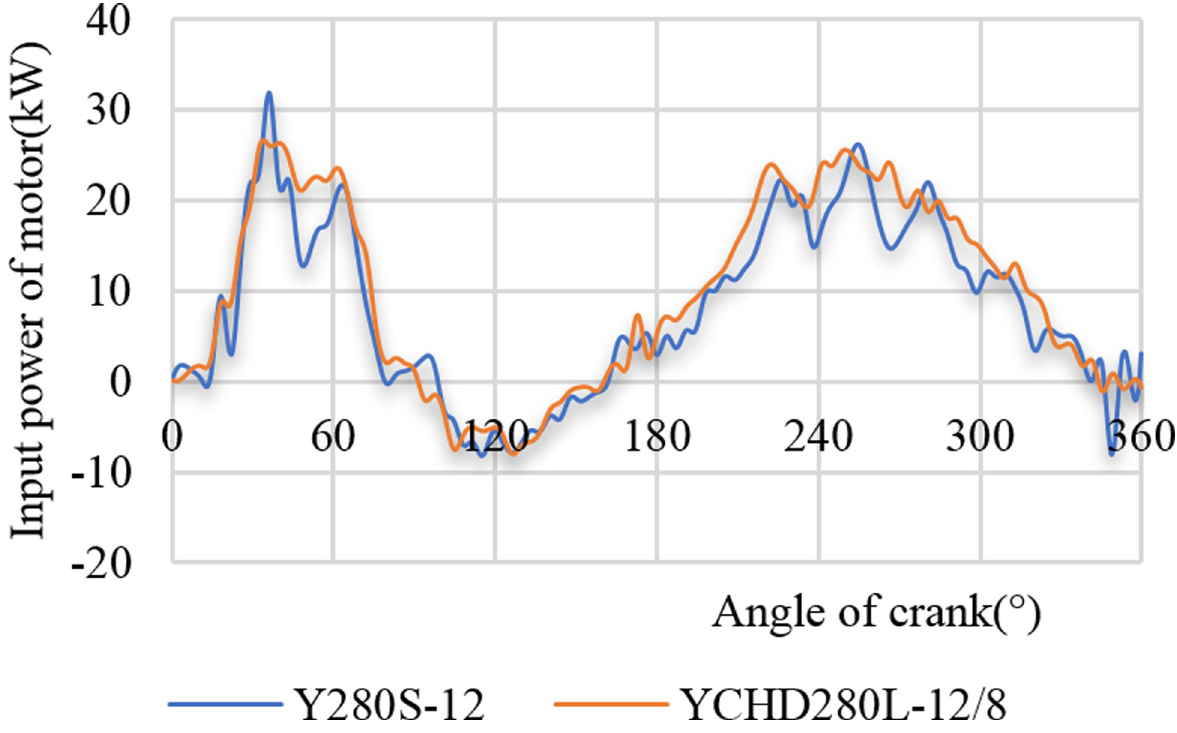
Fig 13. Comparison of two motor power curves.